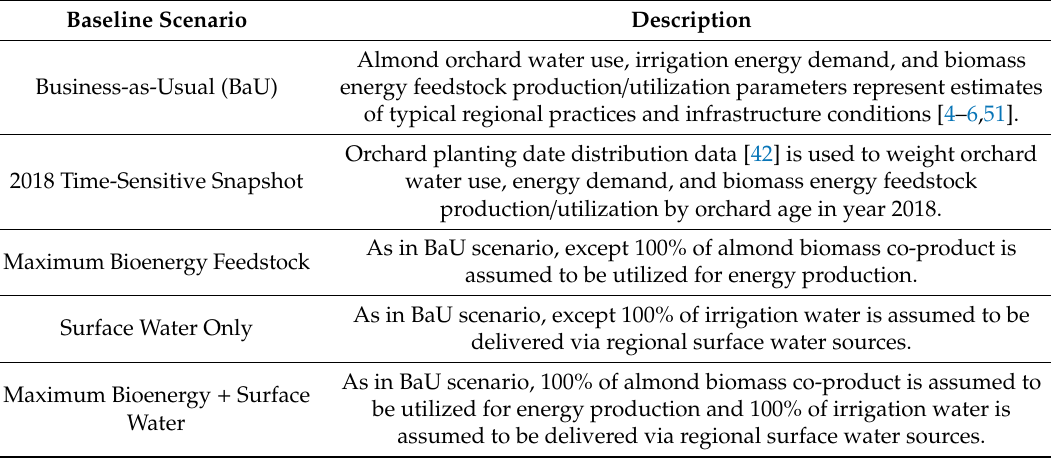
Table 1. Descriptions of modeling scenarios used to generate baseline